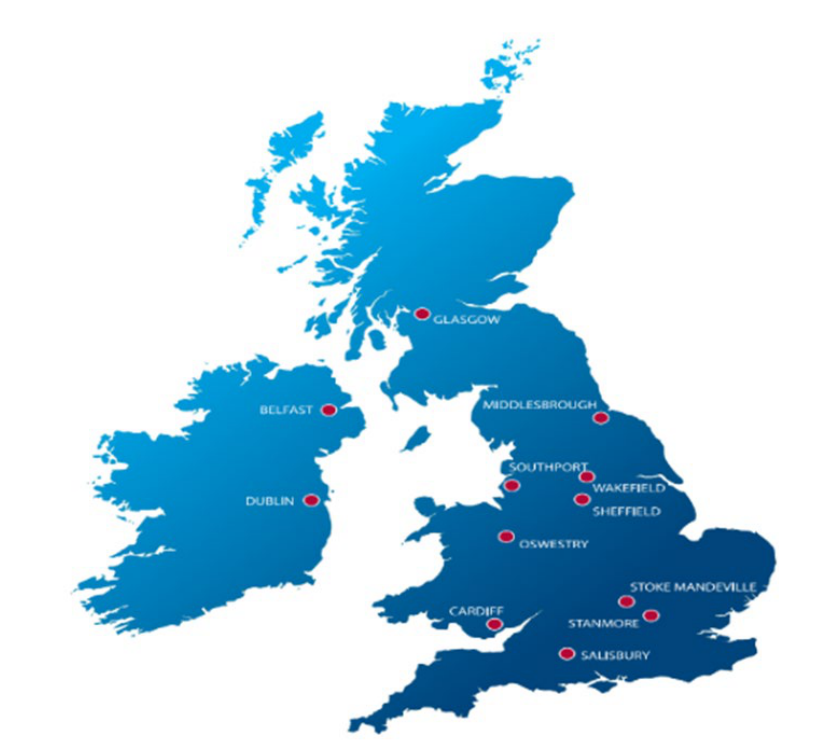
Figure 1. The location of Spinal Cord Injury Centres (SCICs) in UK ("Annual Statement - NHS specialised spinal cord injury services,"